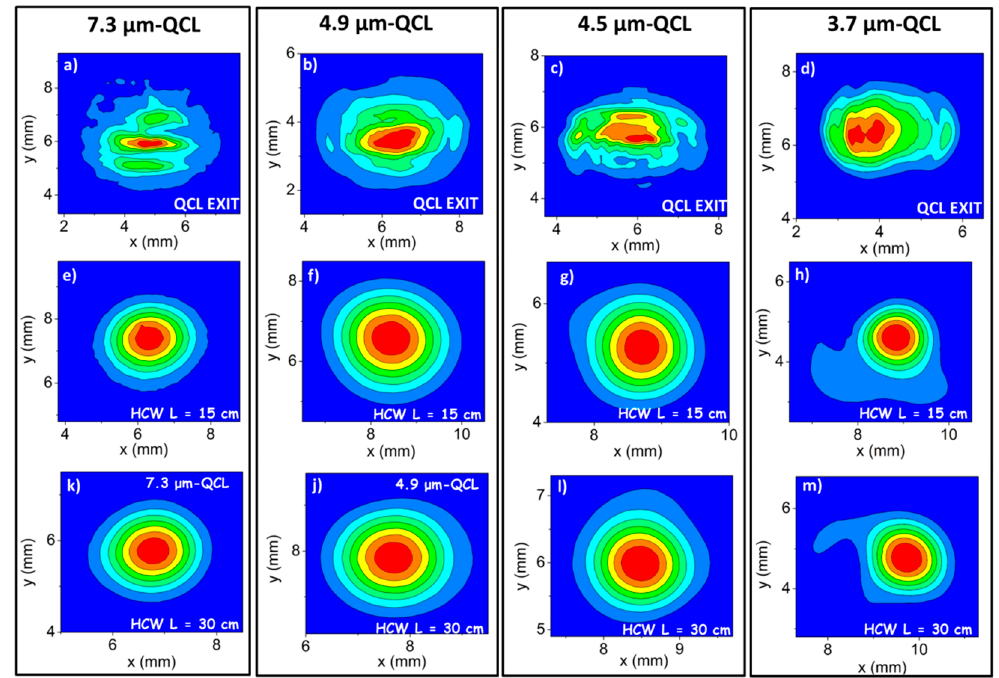
Figure 3. ( a – d ) Beam profiles of the QCL at 7.3 μ m ( a ), at 4.9 μ m ( b ), at 4.5 μ m ( c ), and at 3.7 μ m ( d ), recorded by positioning the infrared pyro-camera 7 cm away from the QCL exit. ( e – m ) The HCW output beam profiles were measured for the 15-cm- ( e – h ) and 30-cm-long ( k – m ) waveguides. The focusing lens was positioned at a distance of 7 cm from the QCL output, and the pyrocamera was located at ~2 cm from the HCW exit.